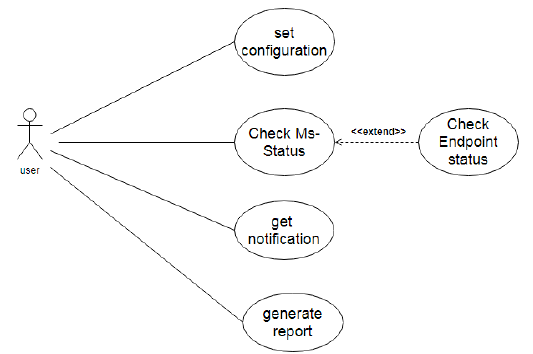
Figure 6. Use Case Diagram of DMM